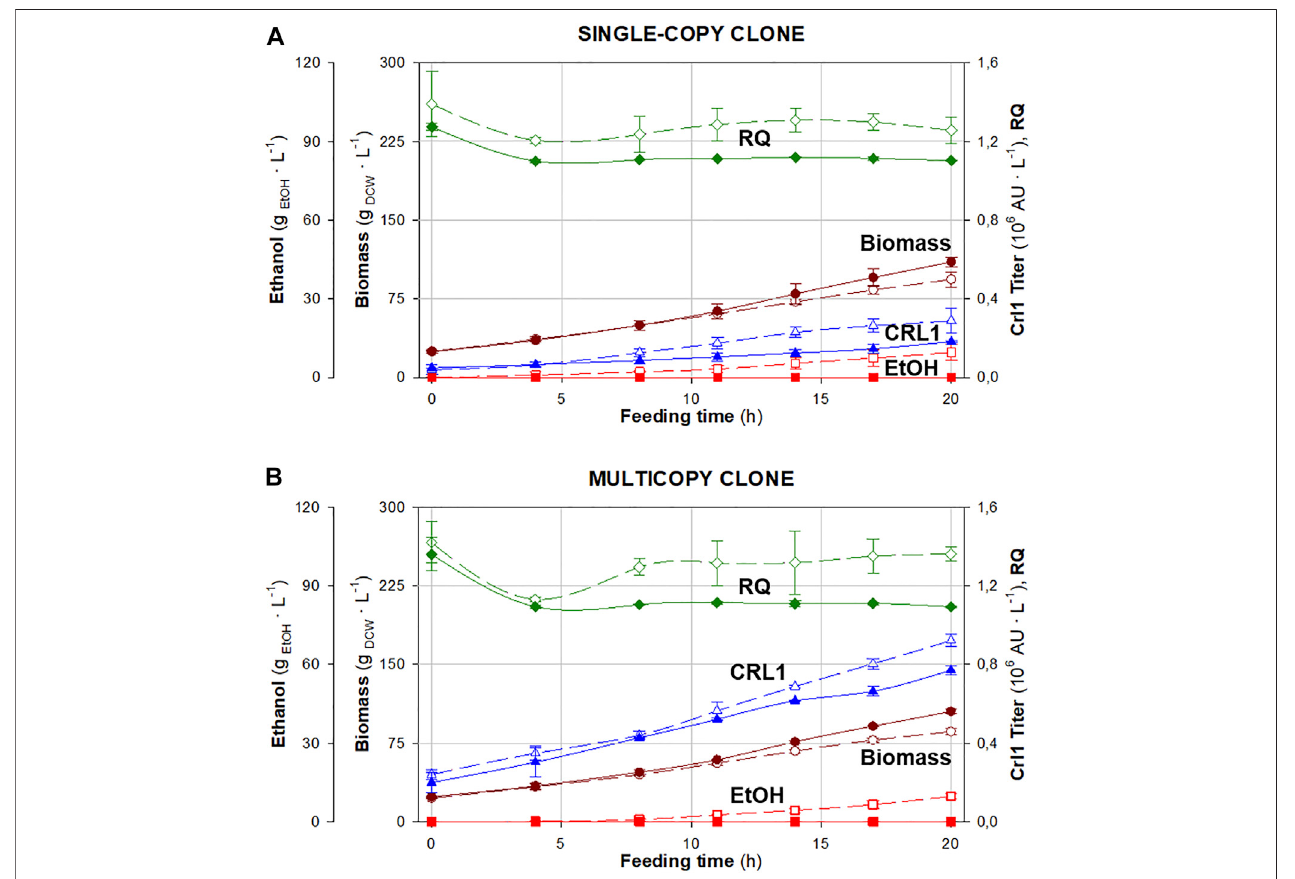
FIGURE3| Timeevolutionofrespiratoryquotient( ◆ ),biomass( C )andethanol( ∎ )concentrations,andCrl1activity( ▲ )infed-batchculturesunderdifferentoxygen transfer conditions: normoxia ( fi lled symbols) and hypoxia (void symbols). (A) Single-copy clone (SCC). (B) Multicopy clone (MCC). Error bars represent the SD of biological replicates.